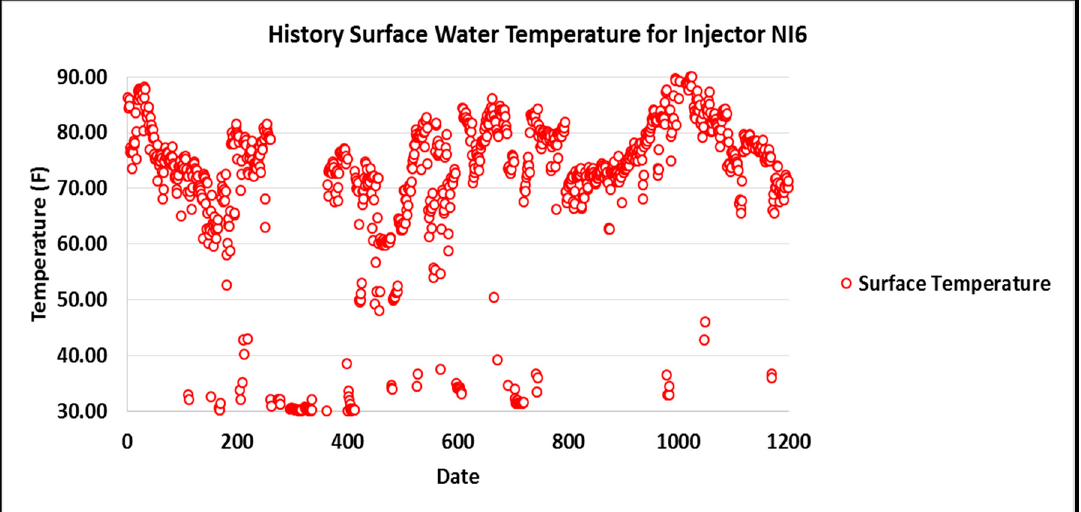
Figure 31. Surface water temperature for Injector NI6.